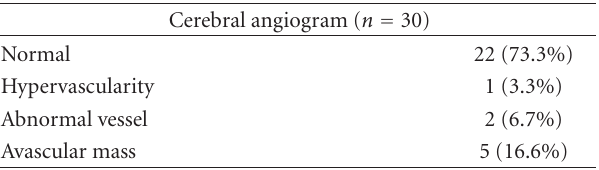
Table 4: Characteristics of meningioangiomatosis on cerebral angi-